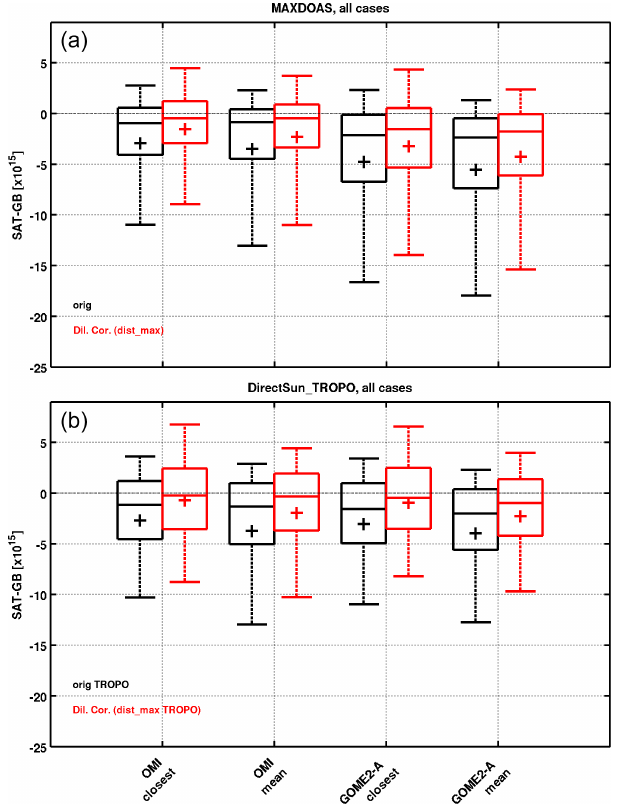
Figure 12. Box-and-whisker plot of the daily biases for all the sta- tions with (red) and without (black) dilution correction (see Sect.